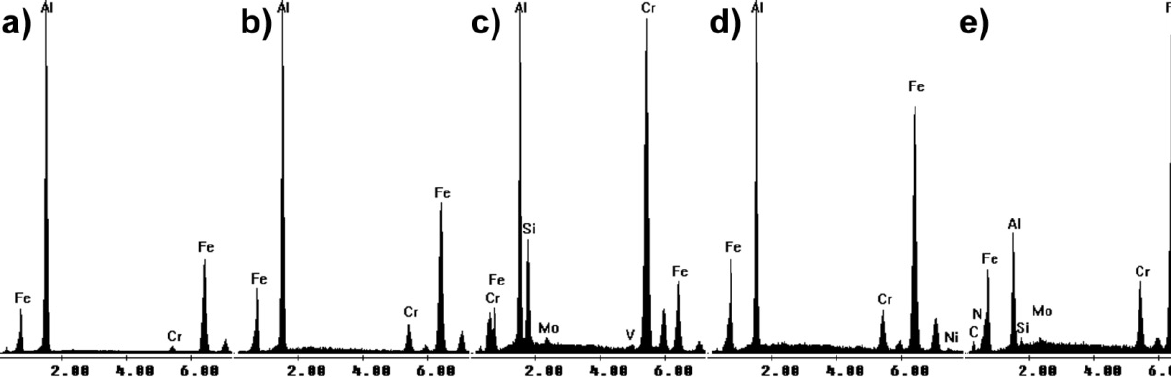
Figure 6. EDS analyses for a cross section of unexposed aluminized P91 (Figure 5 a)). All compositions are given in at-%. a) Al 5 Fe 2 (70.6 % Al, 28.2 % Fe, 1.2 % Cr). b) AlCr 2 (60.4 % Al, 35.2 % Fe, 4.4 % Cr). c) Cr 3 Si (38.3 % Al, 37.6 % Cr, 12.3 % Si, 11.2 % Fe, 0.4 % Mo, 0.3 % V). d) AlFe (50.2 % Al, 44.5 % Fe, 4.5 % Cr, 0.8 % Ni). e) AlN pre-